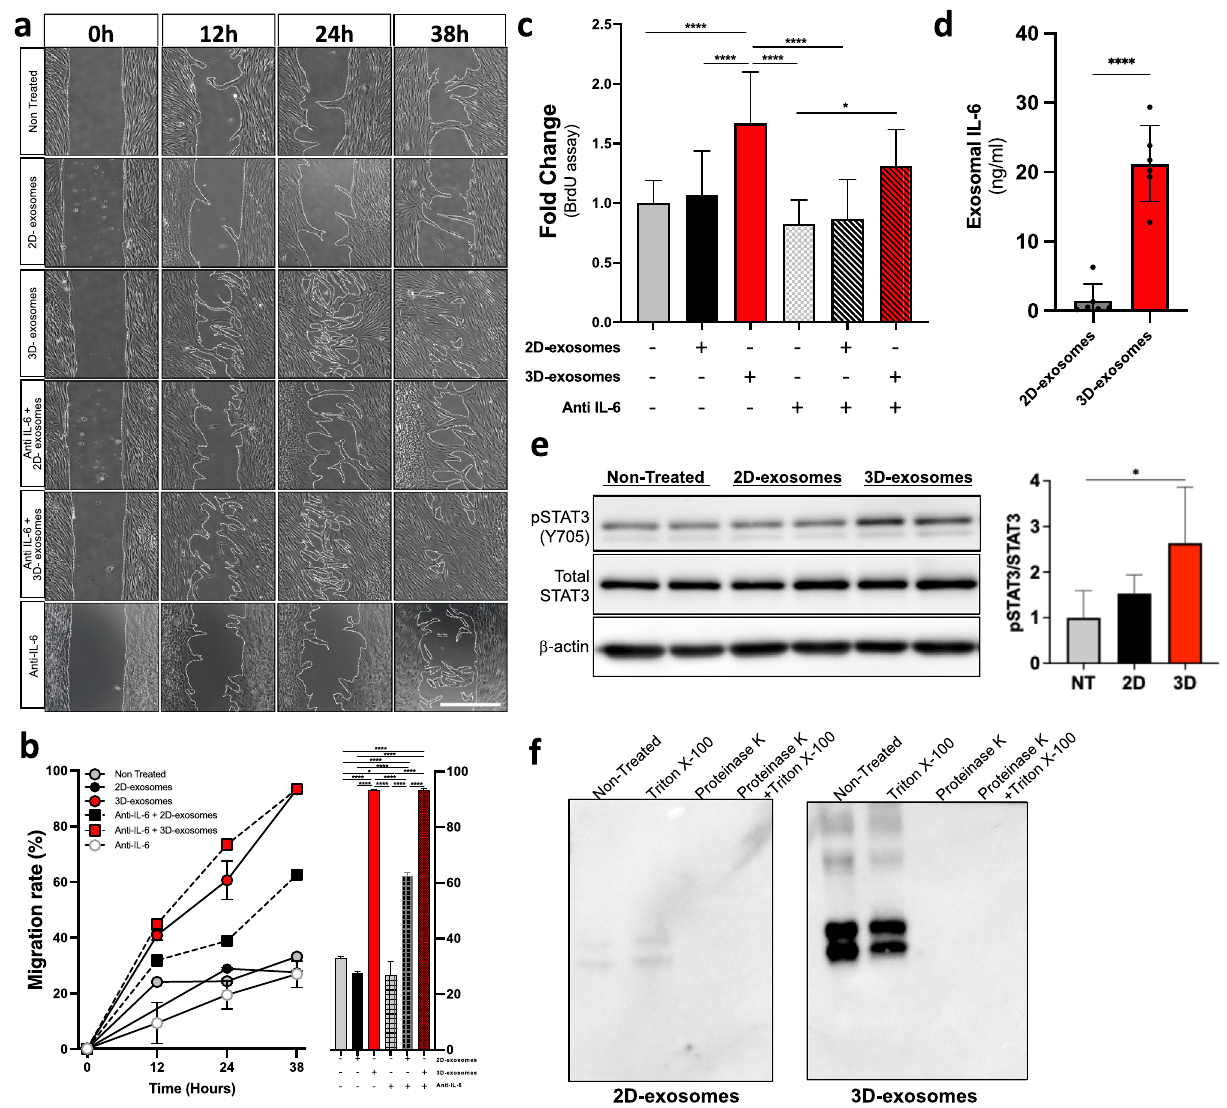
Figure 7. Cellular migration and proliferation are partially regulated through the IL-6 signalling pathway. In vitro scratch assay evaluating the effect of exosomes and anti-IL-6 treatments on the migration of dermal fibroblasts according to the culture method ( a , b ). Fibroblast were pre-treated with 250 μg of exosomes with or without 2 μg/mL anti-IL-6 prior to the assay and retreated with 250 μg of exosomes at the initial time point. Exosomal treatments were composed of a pool of an equal part of the six populations. Images were captured at various time points (0, 12 h, 24 h and 38 h) and closing rate was measured by reporting the total scratch area at each time point to the area at the initial time. Scale bar = 500 μm. n = 3. Cell proliferation ratio of fibroblasts treated with 2D- or 3D-exosomes and anti-IL-6 using a BrdU cell proliferation ELISA assay ( c ). Ratios were reported as a fold change compared to the non-treated condition. n = 9–18. Quantification of secreted IL-6 by ELISA ( d ). Exosomal IL-6 concentration is represented in ng/mL and normalised to the number of cells (gDNA). n = 6. Phosphorylation level of STAT (Tyr705) in fibroblasts treated with both types of exosomes ( e ). Phosphorylation levels were report to total STAT3 and are shown as fold change, relative to the non- treated control. n = 3. Exosomal localization of IL-6. Equivalent amounts of all samples were resolved with SDS-PAGE and subjected to Western blotting. Note that the cropped images only are shown for conciseness; see supplementary figures section to see the original blots (f). Microparticles were treated with 100 mg/mL proteinase K and/or 1% Triton X-100. An equal amount of total exosomal proteins were then analysed by Western blot. Note again that the cropped images only are shown for conciseness; see